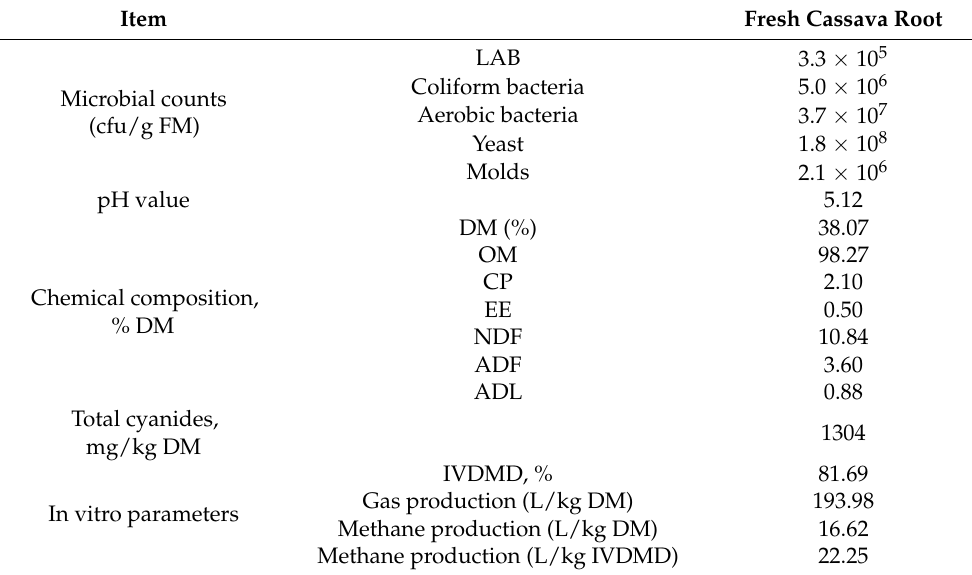
Table 1. Microbial counts, pH, chemical compositions, and in vitro rumen parameters at 24 h incubation of fresh cassava root material used to prepare silage in this study.